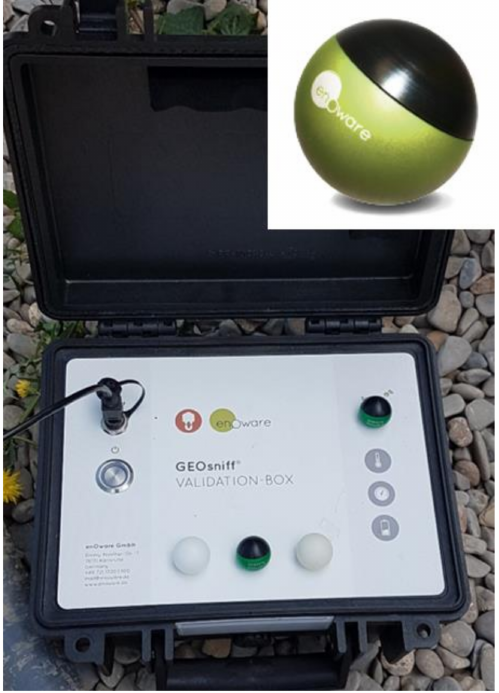
Figure 2. The GEOsniff Validation Box with two GEOsniff sensors (green/black balls) and two blind balls (white), which are for checking the recoverability of the real